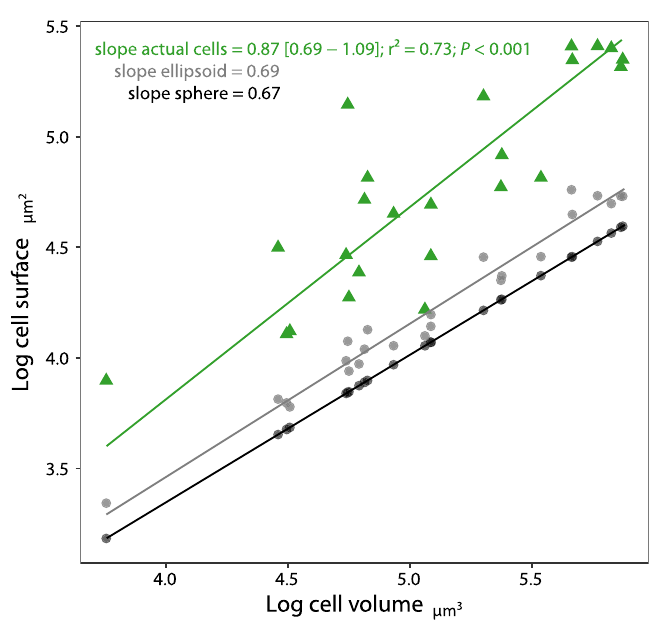
Figure 4. Comparison of surface area to volume scaling of Micrasterias cells (green triangles) and modelled theoretical shapes. Grey points represent spheres with a volume equal to actual cells. Black points represent ellipsoids with equal volume and same axis proportions (i.e. same global flattening). Only actual cells that are both flattened and with fractal-like morphology depart from Euclidean scaling (2/3). Lines represent SMA regressions and variables are log10-transformed. *** P value <